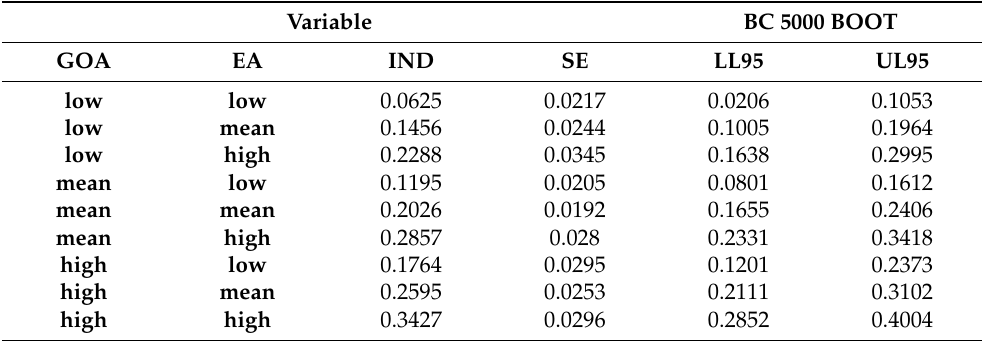
Table 8. Double conditional indirect effect of green shared vision–OCBE link at specific levels of green organizational ambidexterity (GOA) and environmental attitude (EA).